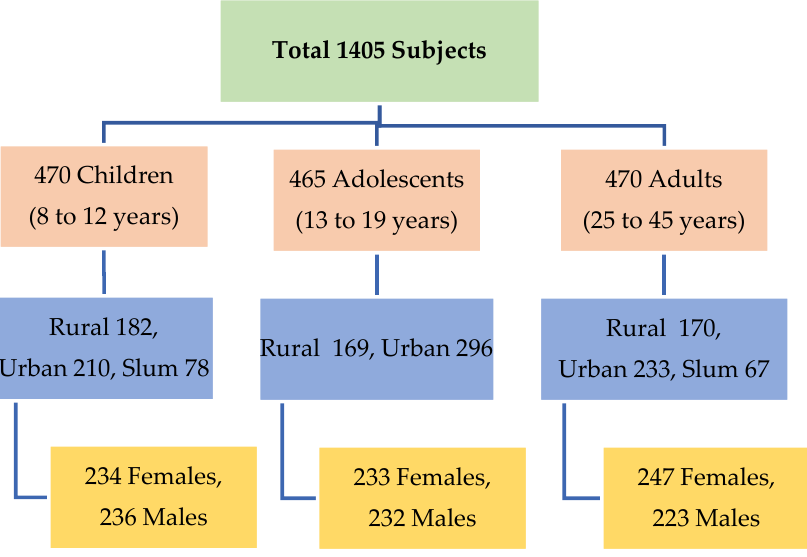
Figure 1. Setting and study participants. An equal number of adolescent male and female were from low and mid SES. Of the female adolescents, 39% belonged to mid SES and 25% to low SES. Among the male adults, 44% belonged to low SES and 36% to mid SES. Children (10 to 12